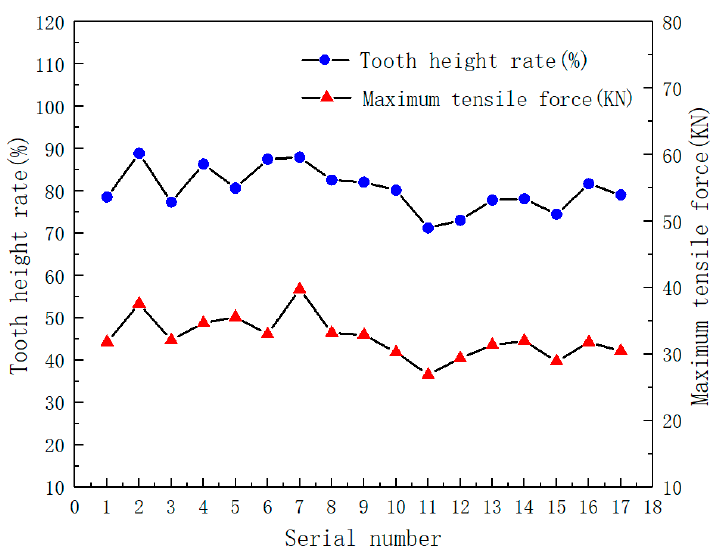
Figure 8. Relationship between tooth height rate and maximum tensile force.